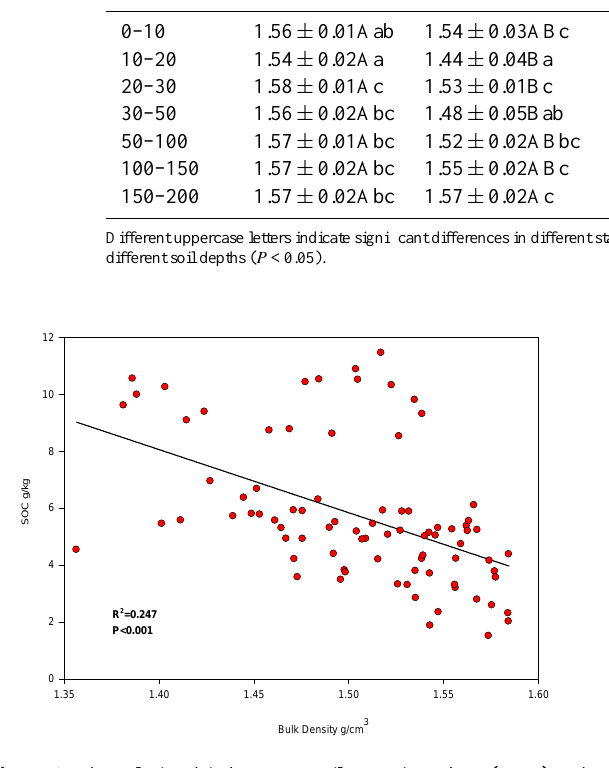
Figure 2. The relationship between soil organic carbon (SOC) and bulk density of S. cheilophila .